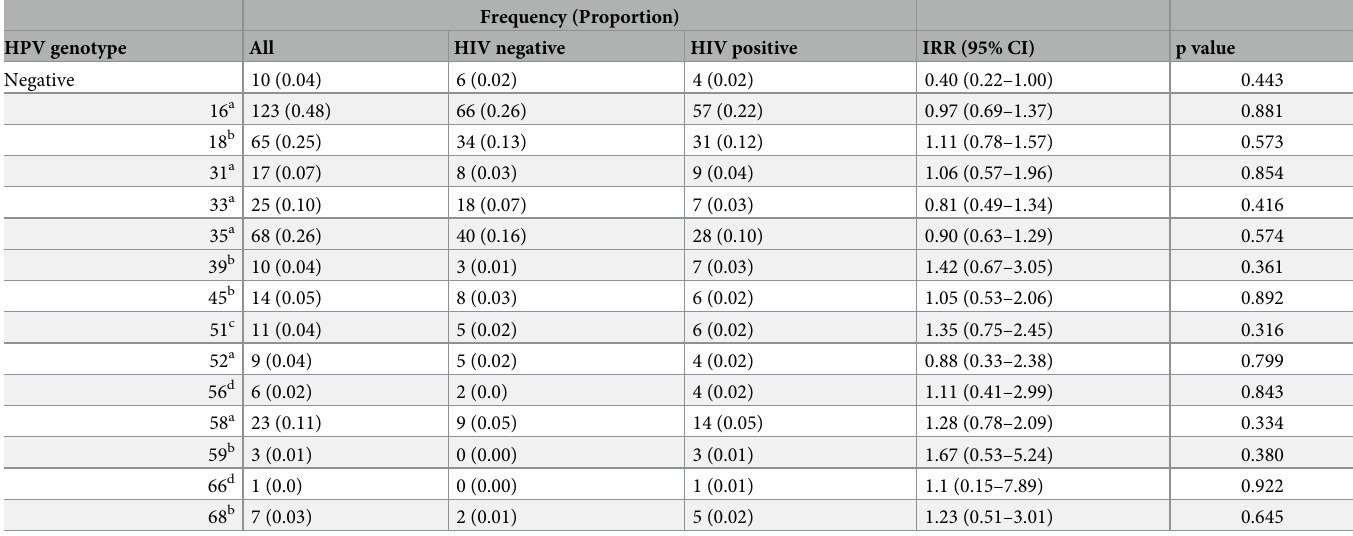
tive odds ratios and 95% confidence intervals for all significant HPV genotypes are shown in Fig 4. In order to ensure that lack of significance observed was not a result of low study power, a sensitivity appraisal was conducted, using multivariate regression analyses controlling for age, history of sexually transmitted infections, parity, HIV status, age at sexual debut and Table 2. HR-HPV genotypes by HIV status (n = 258) and the HPV phylogenetic classification. Frequency (Proportion) HPV